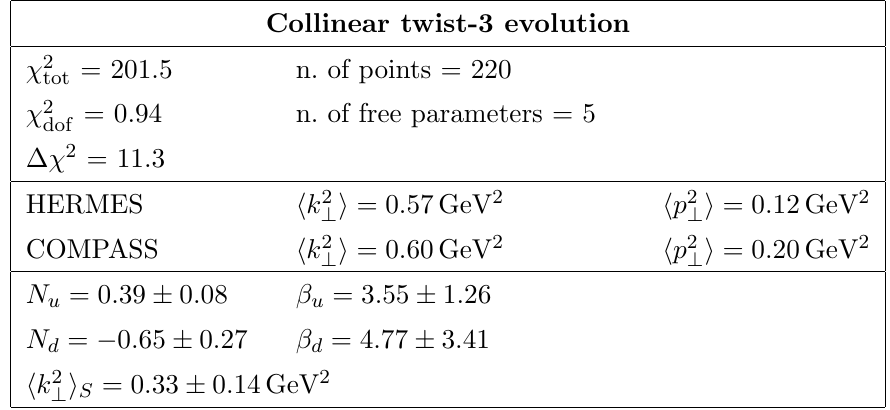
Table 4 . Best (cid:12)t parameters and (cid:31) 2 values for the collinear twist-3 evolution case. The parameter errors correspond to 2 (cid:27) C.L. Notice the reduced value of (cid:31) 2